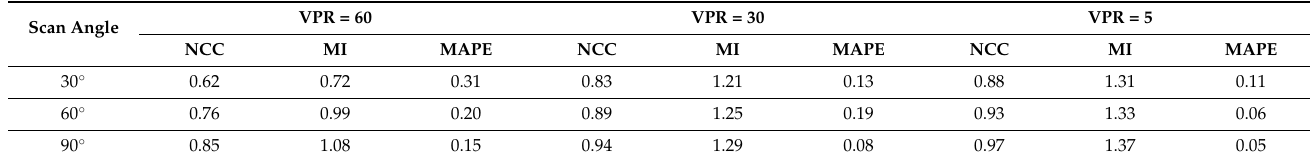
Table 1. The accuracy of the B-spline-interpolated displacement matrix.